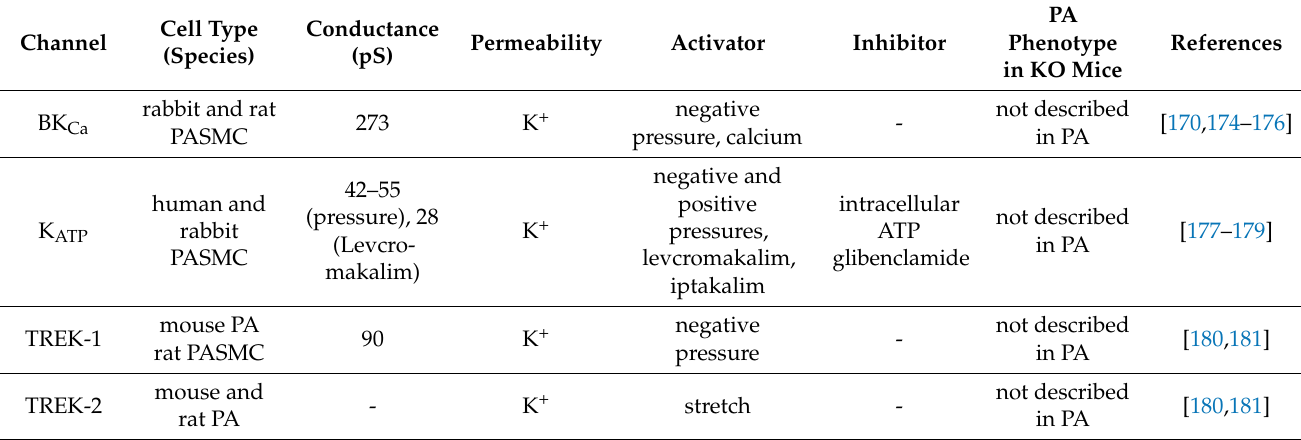
Table 3. Biophysical properties of mechanosensitive K + channels in pulmonary arterial vascular cells.